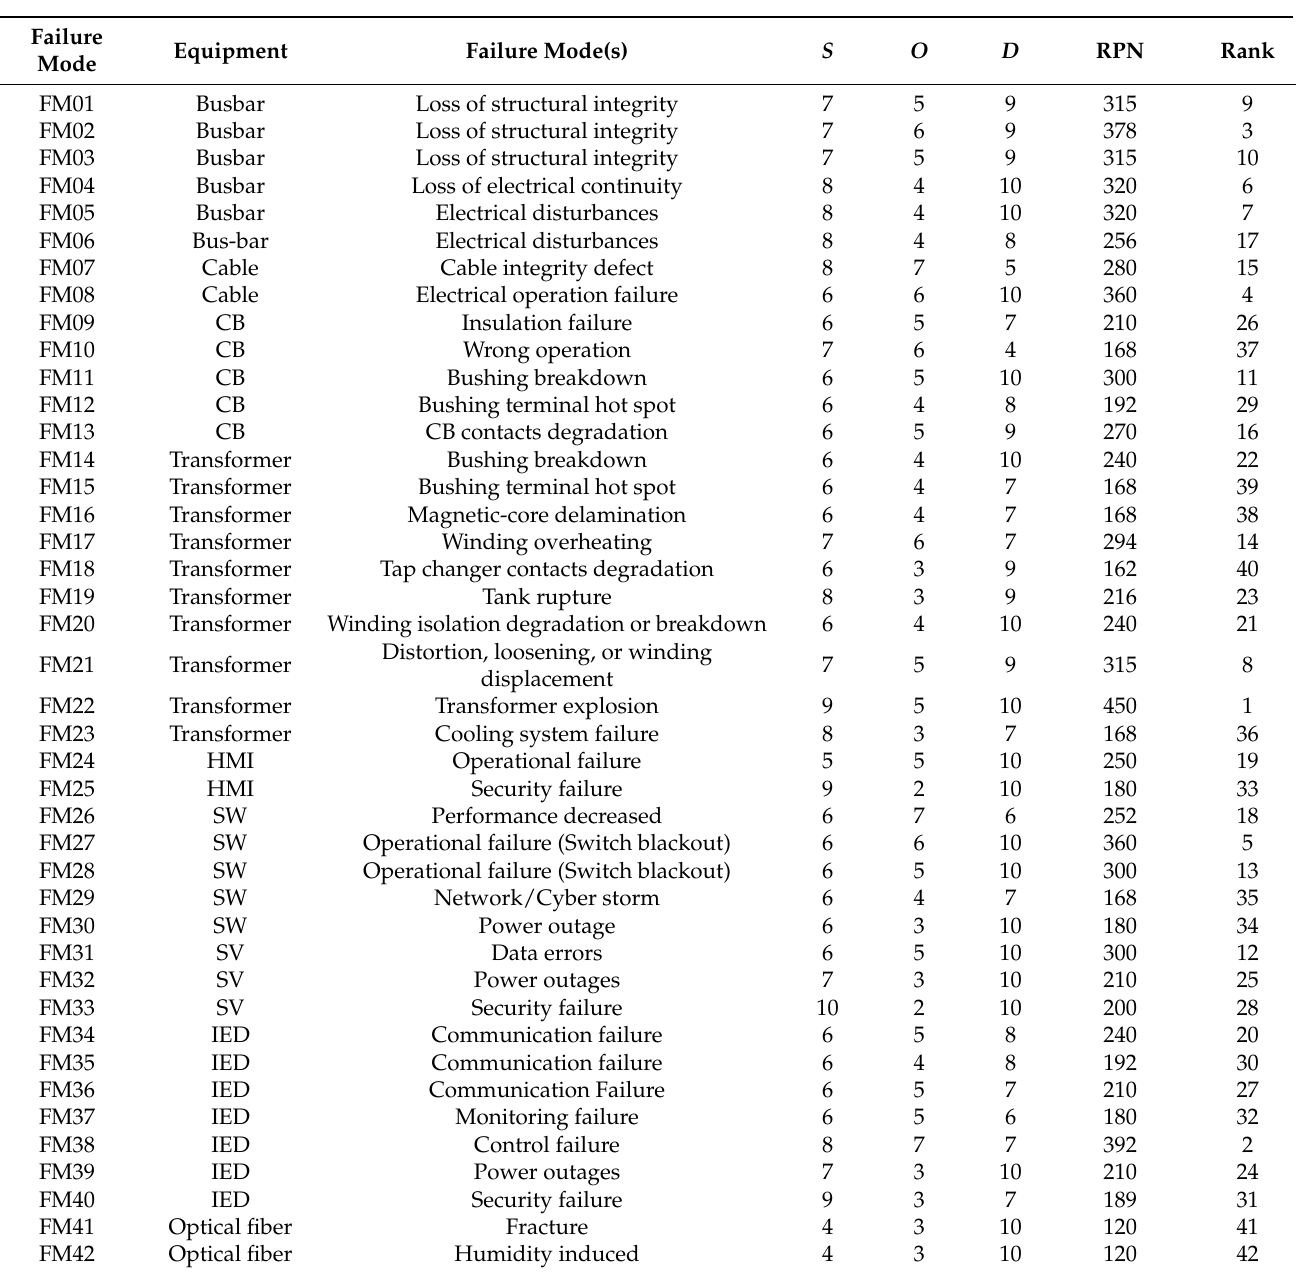
Table 8. Classical FMECA applied to the cyber-power grid test system shown in Figure 1 (based on [12]).